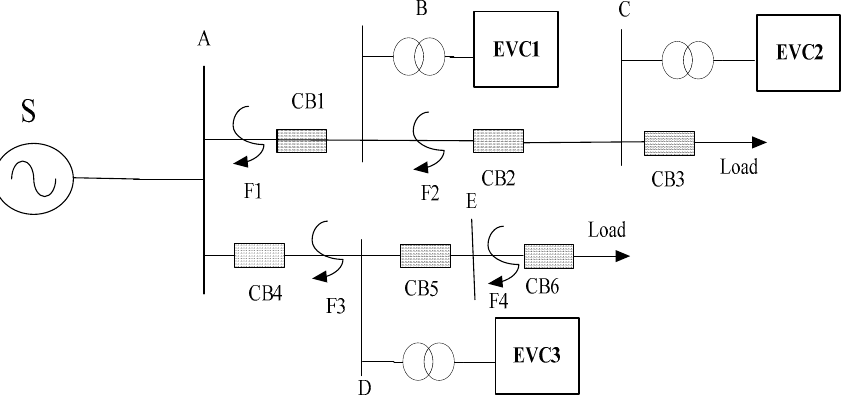
Figure 1. Schematic diagram of distribution network with charging and discharging stations. Where A, B, C, and D are the bus